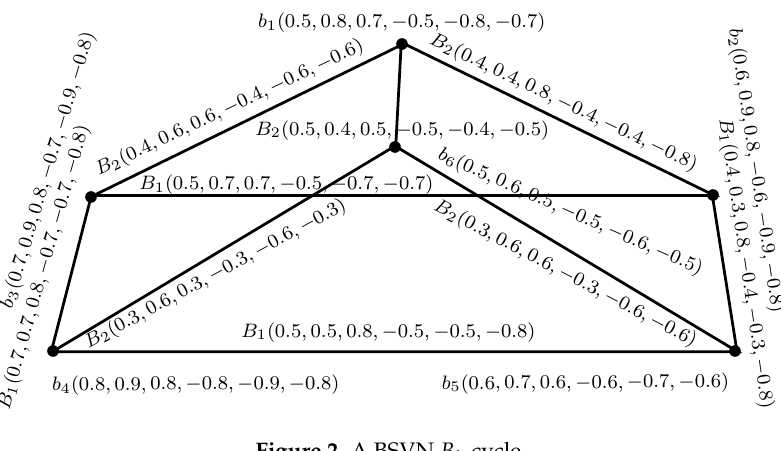
Figure 2. A BSVN B 1 -cycle.